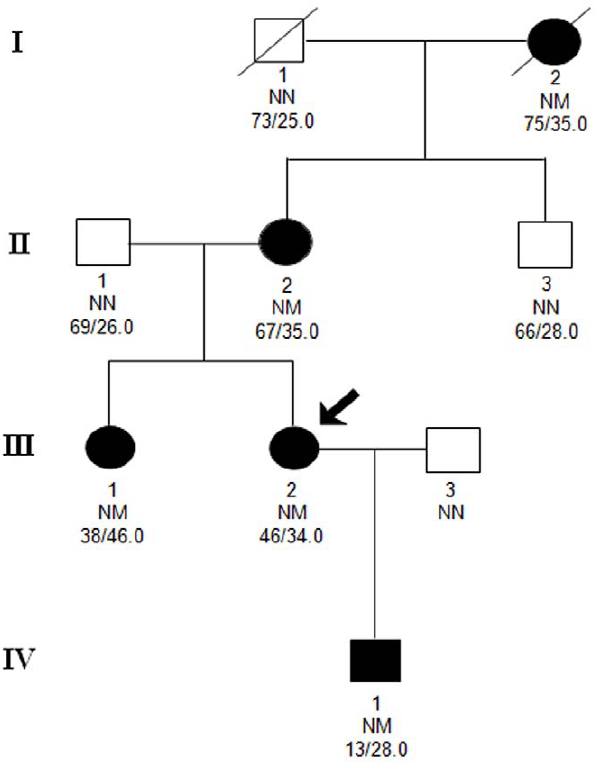
Figure 1. Pedigree of Danish family carrying the 2 151 GHSR promoter variant. Filled symbols indicate obese subjects. For subjects aged 18 years or older, obesity was defined as a BMI $ 30 kg/m 2 , for children international cut off points for obesity were used to define obesity (Cole, Bellizzi, et al. 2000 428/id). The index patient is indicated by the arrow. The roman number refers to generation and the text below each individual represents the following: family-specific identification number; genotype NN, no mutation; NM, heterozygous GHSR 2 151C . T mutation and age (years)/maximal BMI (kg/m 2 ). DK-III-3 was not available for medical exams or interviews for this study. DK-X-Y (Danish family, generation X and person ID Y). The index patient (DK-III-2). was seen for all obese individuals in the Czech pedigree (Figure 2). The children CZ-III-2 and CZ-III-4 (Figure 2) were also carriers of the mutation with BMIs of 22.0 (Z-score: + 0.04) and 21.1 (Z- score: + 0.3) kg/m 2 , respectively, which is above the age and sex- adjusted 50 th percentile. When linkage analysis was performed in the Danish and Czech pedigrees they showed a LOD score for obesity at the GHSR locus of Z = 1.7.